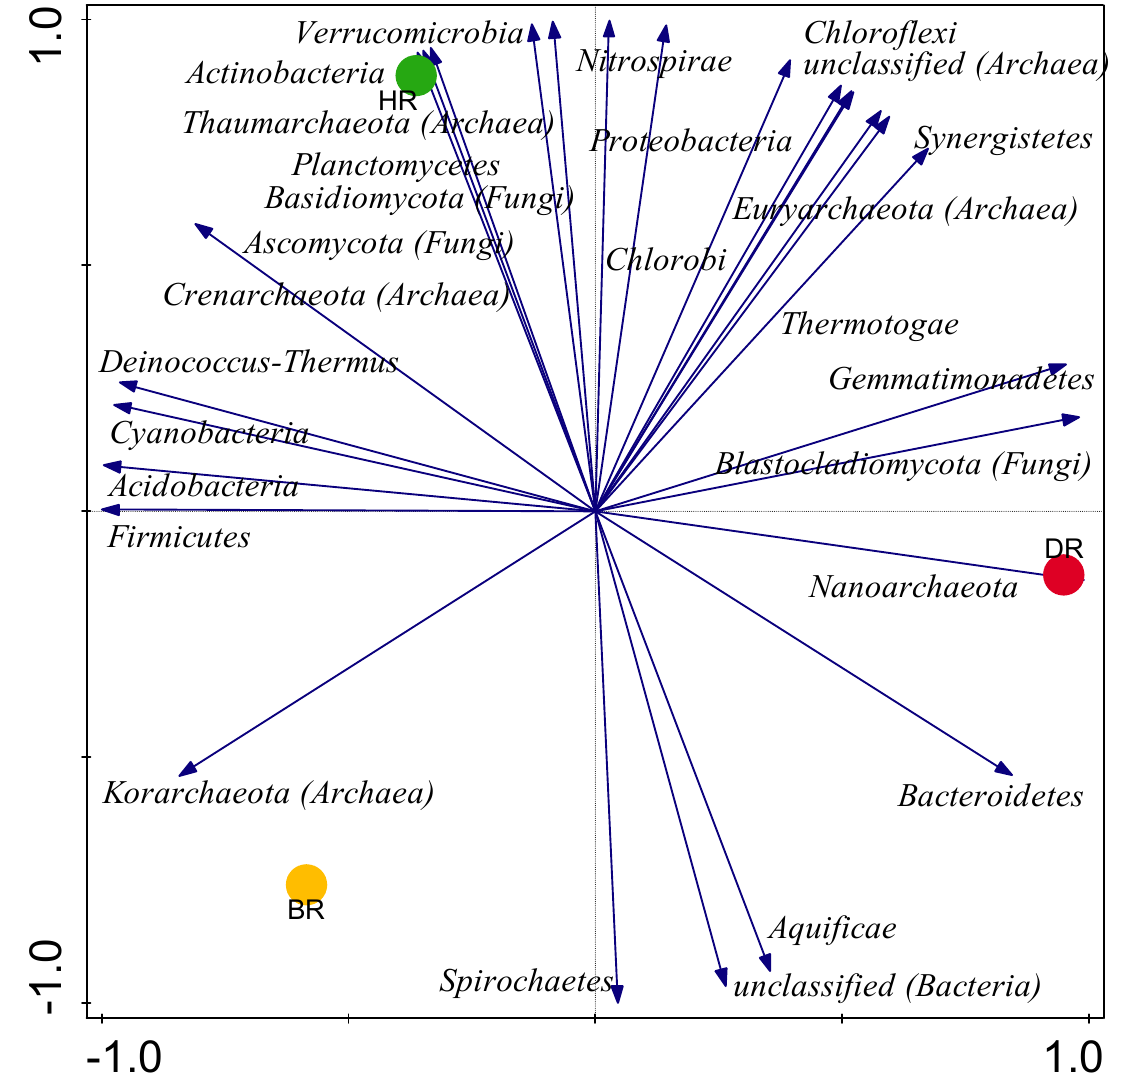
Figure 2. PCA graph of phyla of the community of microbes present in the rhizosphere and bulk soils. Each arrow shows the impact of the microbial metagenomes, axis 1 (59%) and axis 2 (41%) explain the variations, employing the Bray–Curtis dissimilarity matrix. HR = rhizosphere soil of healthy tomato plant; DR = rhizosphere soil of diseased tomato plant; and BR = bulk soil obtained from the soil without tomato plantation.